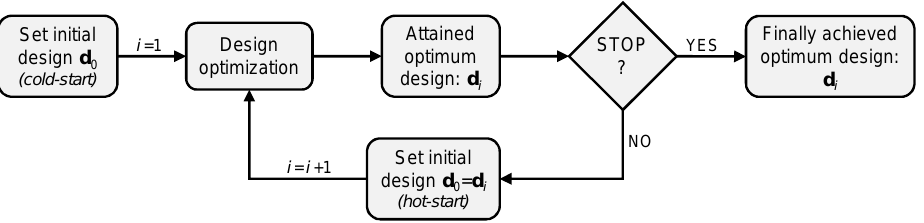
Figure 1. Flowchart of the cascade structural optimization